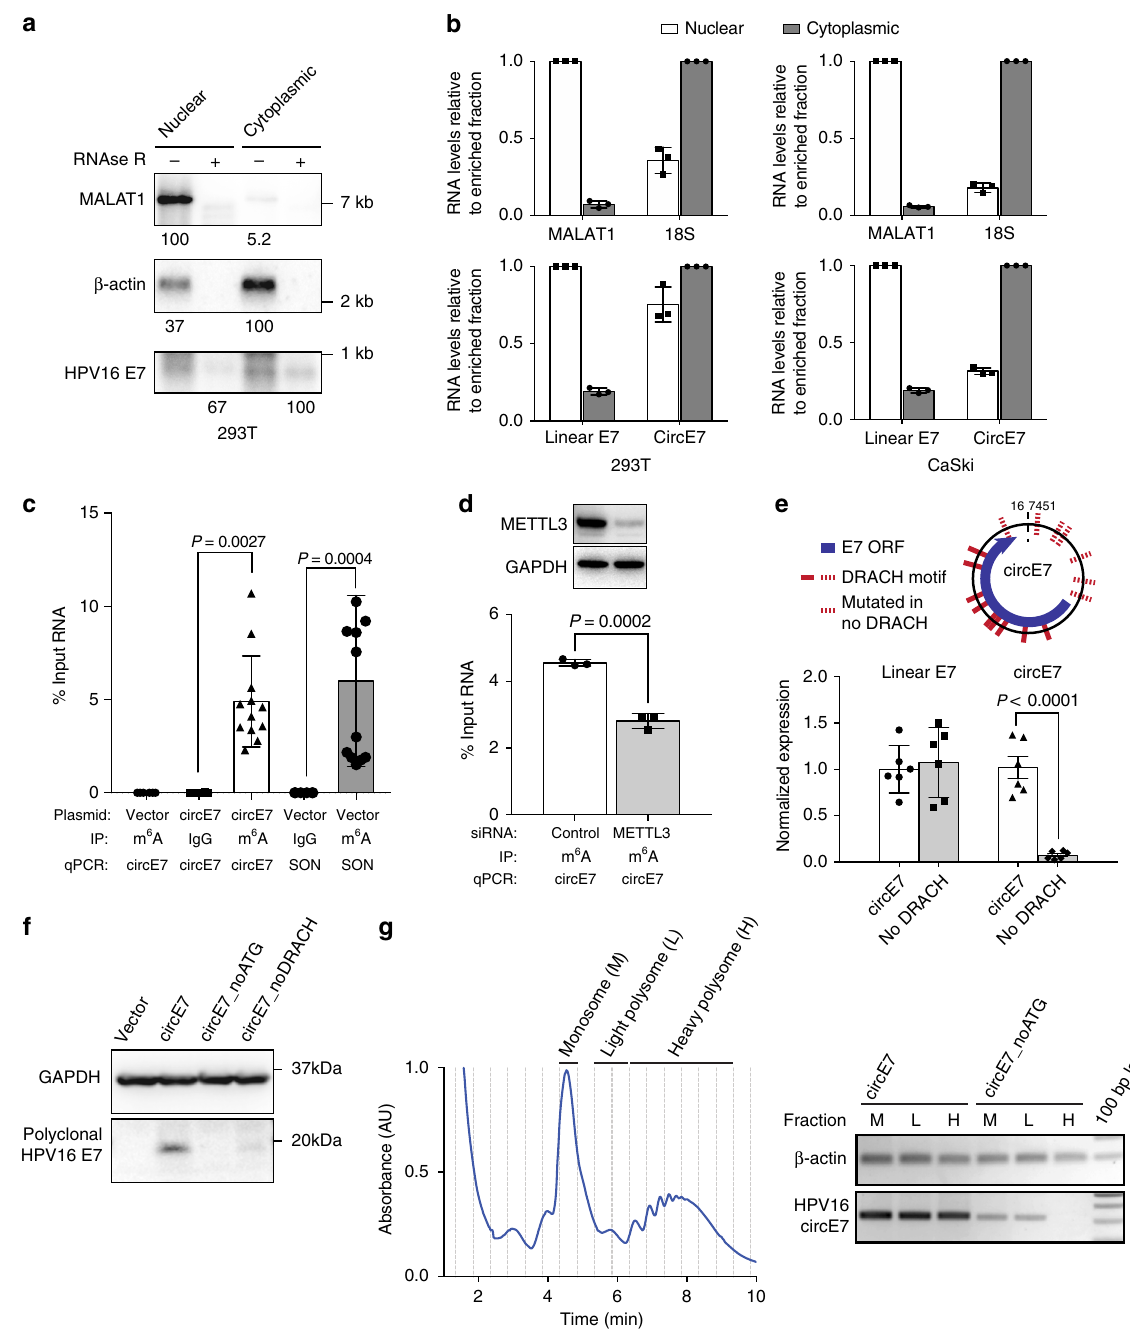
Fig. 3 Characterization of circE7. a CircE7-transfected cells were fractionated and indicated fractions analyzed by northern blot. Total RNA (4 μ g) with mock or RNase R treatment of fractions from 293T cells con fi rms that circE7 is enriched in the cytoplasm and is RNase R-resistant. MALAT1 and β -actin, fractionation controls. Band density (bottom) quantitated after normalization to the enriched fraction. Results are representative of 3 independent blots. b CircE7-transfected 293T (left) or untransfected CaSki (right) were fractionated and analyzed by RT-qPCR. MALAT1 and 18S (top), fractionation controls. Values normalized to the enriched fraction. Results are representative of 3 independent fractionation experiments. c RT-qPCR of RNA IP (m 6 A or IgG control) after transfection with the indicated plasmid (24h) ( n = 8 biological replicates from 4 transfections). SON, m 6 A RNA IP control. d Western blot for METTL3 from 293T co-transfected with control or METTL3 siRNA and circE7 construct (top). GAPDH, loading control. RT-qPCR of RNA IP (m 6 A or IgG control) from 293T cells co-transfected with indicated siRNA and circE7 construct. RT-PCR is representative of 4 independent experiments. e Schematic of the DRACH consensus motifs for METTL3/ 14 and the sites mutated in the circE7_noDRACH construct (top). RT-qPCR for circE7 in cells transfected with the indicated construct. Loss of UTR DRACH motifs in circE7 results in a signi fi cant decrease in the abundance of circE7, but not linear E6/E7. ( n = 4 independent experiments). f Western blot for E7 from 293T transfected with indicated circE7 construct. Data are shown as mean±s.d. P values (indicated above relevant comparisons) were calculated with one-way analysis of variance (ANOVA) with Holm – Sidak tests. g Representative tracing of circE7-transfected cells after polysome enrichment assay with the monosome (M), light polysome (L), and heavy polysome (H) fractions indicated (left). Dashed lines indicate collected fraction. Detection of circE7 in polysome fraction by RT-PCR after transfection with circE7 or circE7_noATG (right). β -actin, control. Source data for a provided in Source Data fi